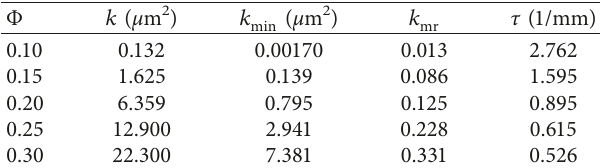
Table 3: Barree–conway seepage model parameters of fractured sandstones with different porosities.